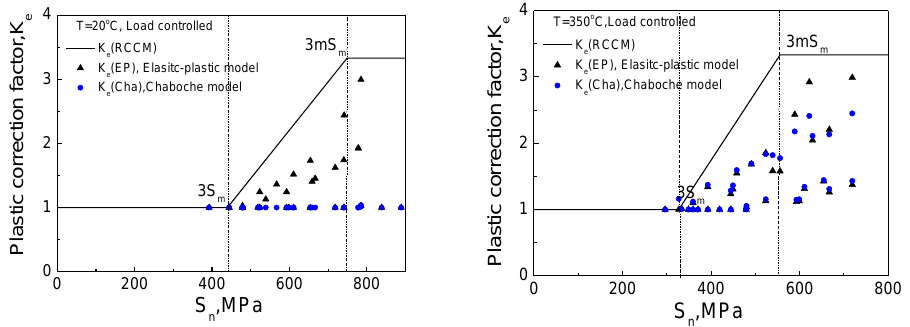
Figure 8. K e with S n under different constitutive models with notched sheet model.